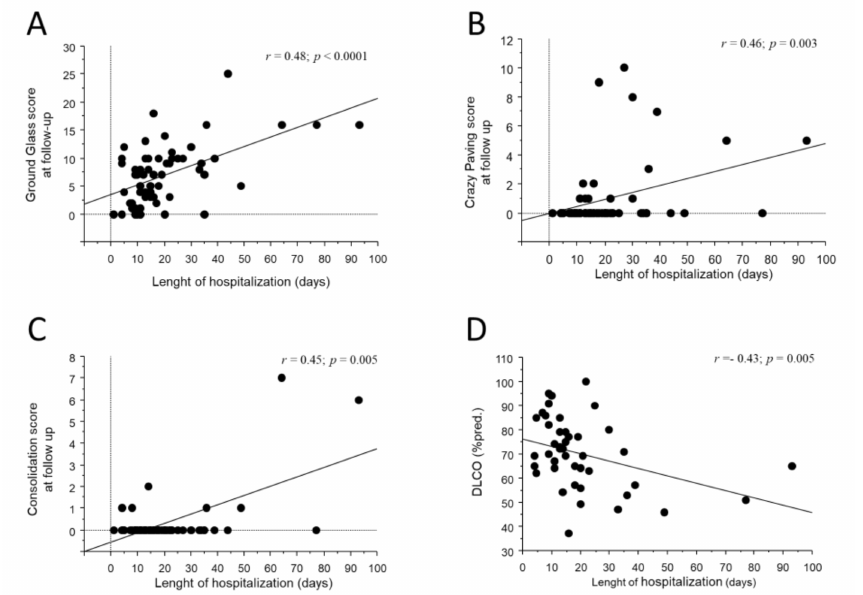
Figure 2. Bivariate scatterplots reporting the relationship between the length of hospitalization ( x axes) and GG ( A ), CP ( B ), CON ( C ) at CT FU and DLCO ( D ) at follow-up visit. Regression line is represented.